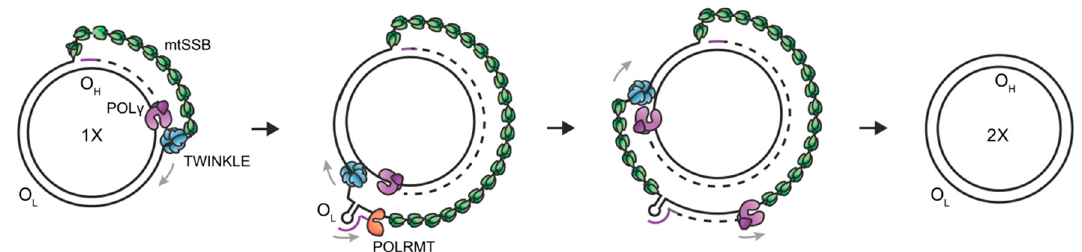
Figure 1 . Strand displacement model of mtDNA replication. Replication of mtDNA is initiated at the heavy strand origin of replication (O H ) by mtSSB, POL γ and TWINKLE and proceeds unidirectionally to produce the full-length nascent H-strand. When the replisome passes the light strand origin of replication (O L ), a stem-loop structure is formed from which POLRMT can initiate the synthesis of the lagging strand primer. Synthesis of the two strands proceeds in a continuous manner to produce two mtDNA molecules.